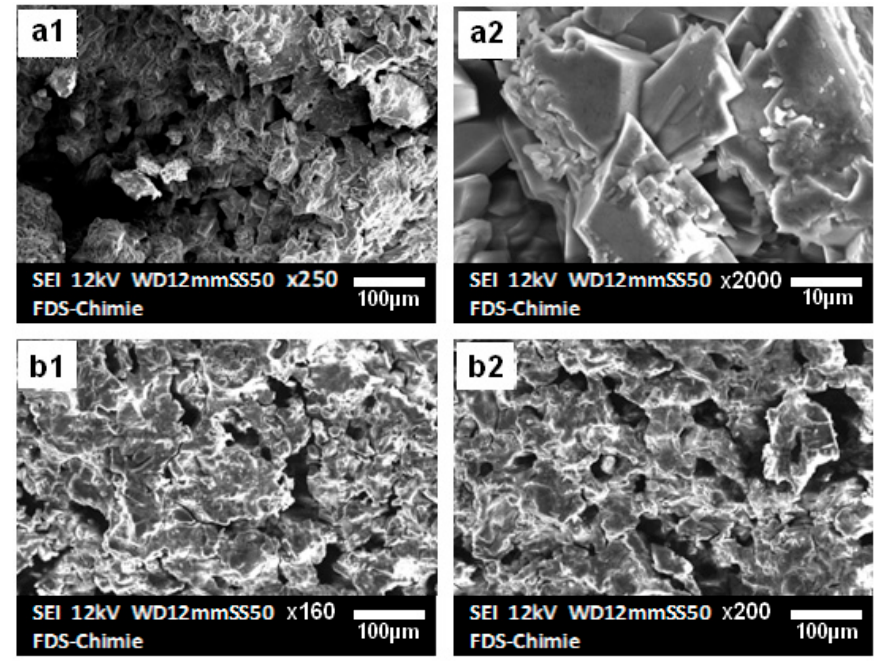
Figure 4. SEM images of pure ( a1 , a2 ) and H 2 O 2 ( b1 , b2 ) cements.